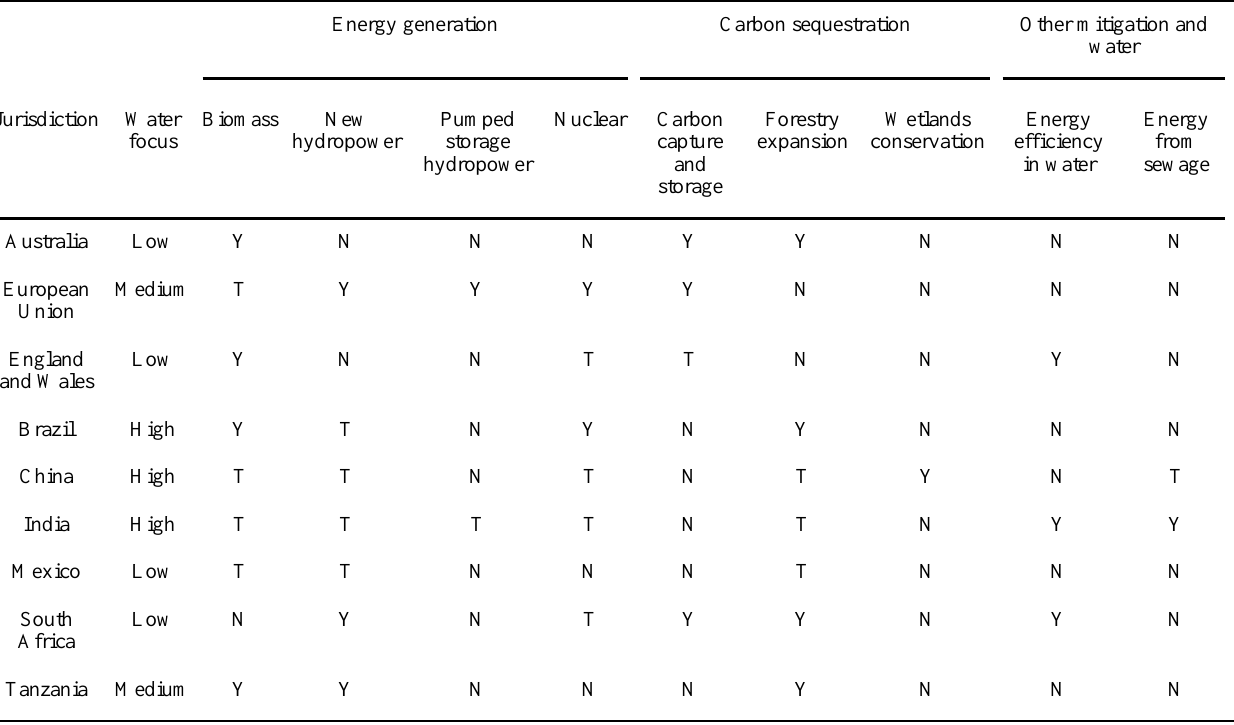
Table 2. Climate policy and water-related greenhouse gas mitigation